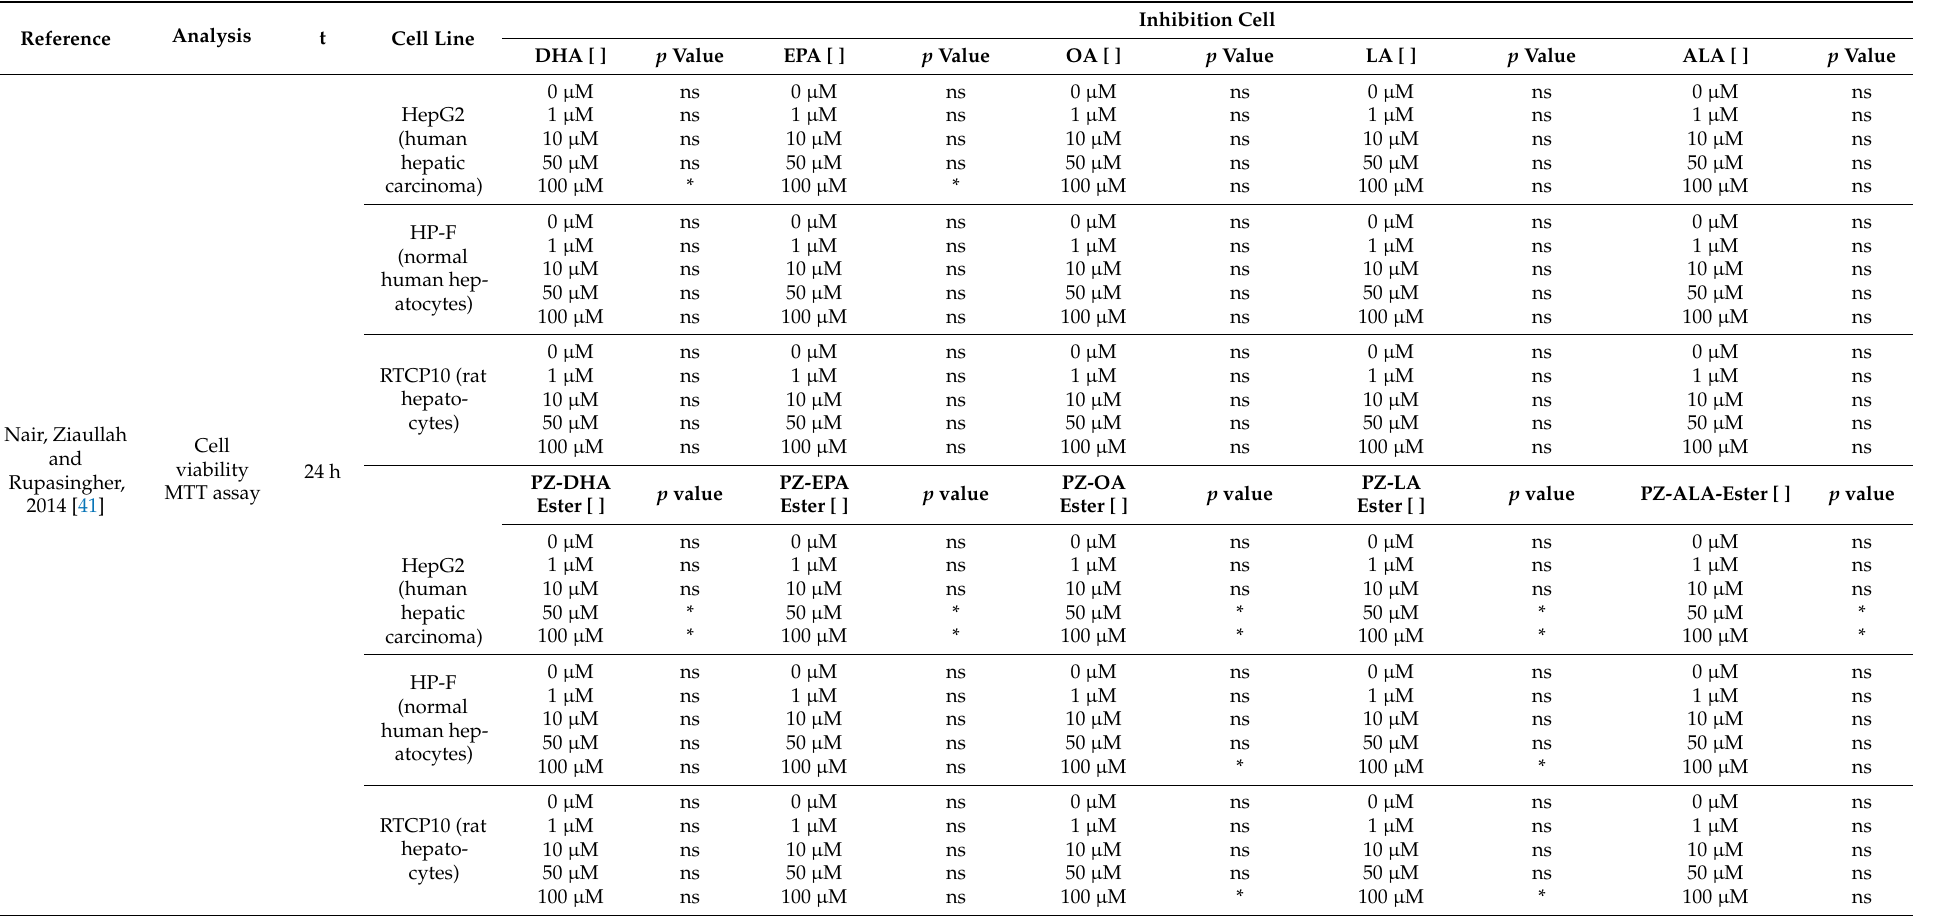
Table 7. Analysis results of the in vitro cytotoxicity tests on liver nontumor and tumor cell